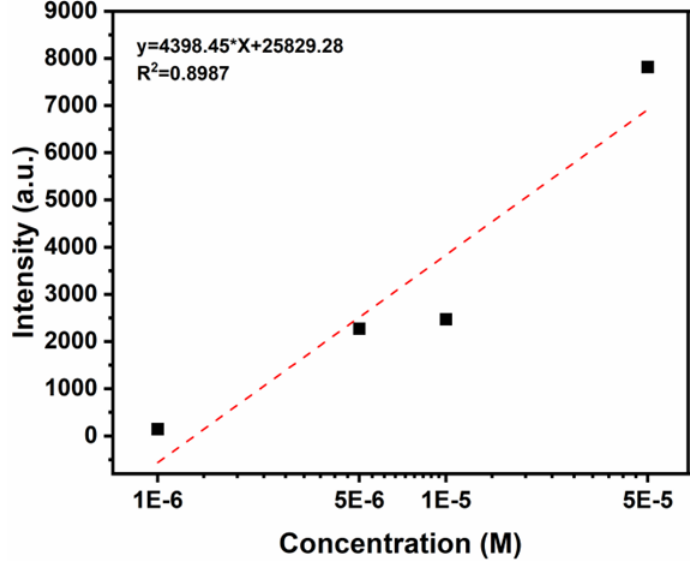
Figure 8. Calibration curve of PDMS-BWS-Ag35 for R6G at different concentrations.